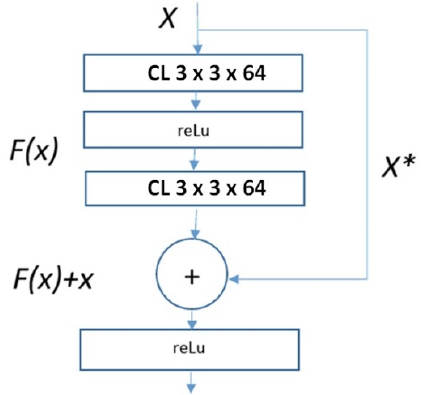
Figure 10. ResNet unit. CL is the convolution layer; reLu is a rectified linear unit.